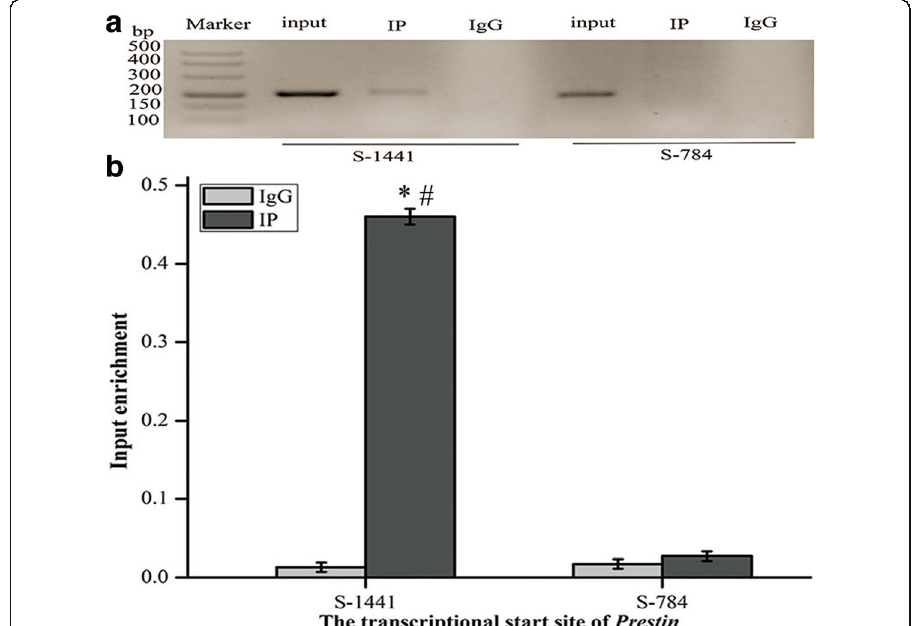
Fig. 3 AP-2 δ bound to Prestin in HEI-OC1 cells, as validated by ChIP assay. a The product of two primers flanking the transcriptional start site (TSS) of Prestin (S-1441 and S-784) was subjected to agarose gel electrophoresis after PCR. An input group, IP group, and IgG group were set up for each site. b Enrichment analysis of AP-2 δ ChIP on Prestin regulatory regions. GAPDH was used as an endogenous control. Enrichment of AP-2 δ -bound Prestin amount was normalized to corresponding amount in input group. The data were presented as the mean ± SD, n = 3 each group. * and # represent P < 0.05 compared with the IgG group of S-1441 and the IP group of S-784